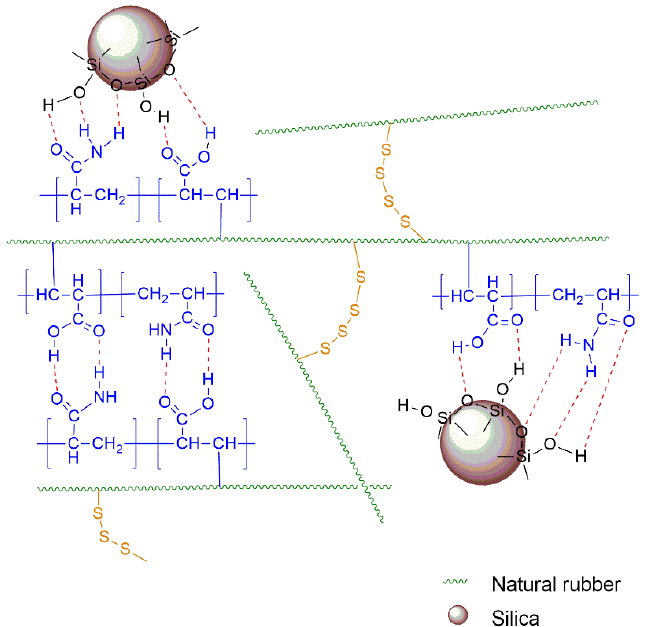
Figure 10. Schematic representation of (PAA- co -PAM)-DPNR/silica interactions.